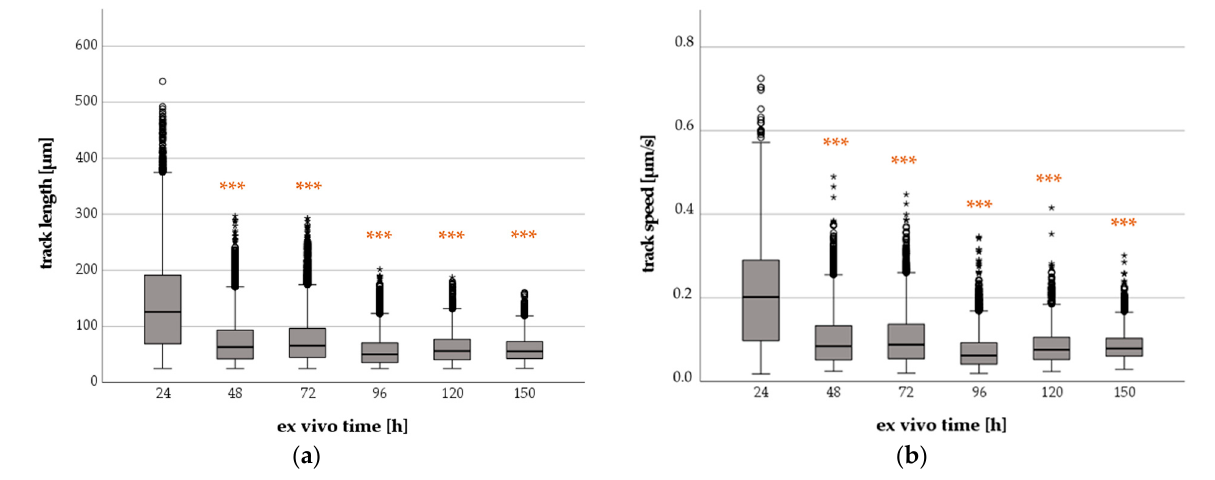
Figure 1. Progress of median TL ( a ) and median TS ( b ) of PMNs with increasing ex vivo time. Significant differences between groups compared with ex vivo time of 24 h are orange colored (*** p < 0.001), small circles in graphics mark statistical outliers ( ≥ 1.5 × IQR) and asterisks display extreme values ( ≥ 3 × IQR).